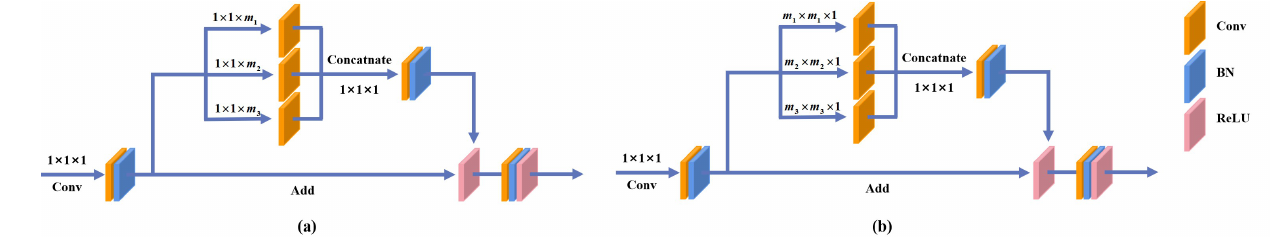
Figure 4. The architecture of the proposed multi-scale spectral/spatial block. ( a ) The multi-scale spectral block (MSpeRB); ( b ) the multi-scale spatial block (MSpaRB). Conv and BN represent the con- volutional layer and the batch normalization, respectively, and ReLU means the activation